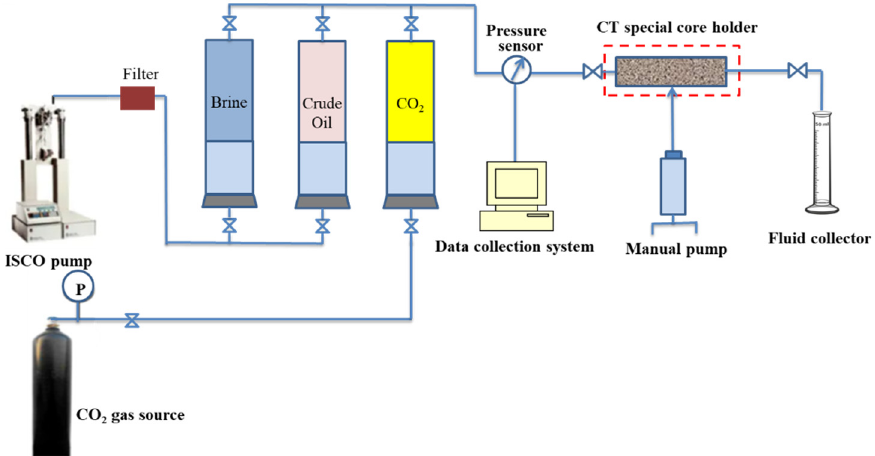
Figure 1. The flow chart of the CO 2 flooding experiment.